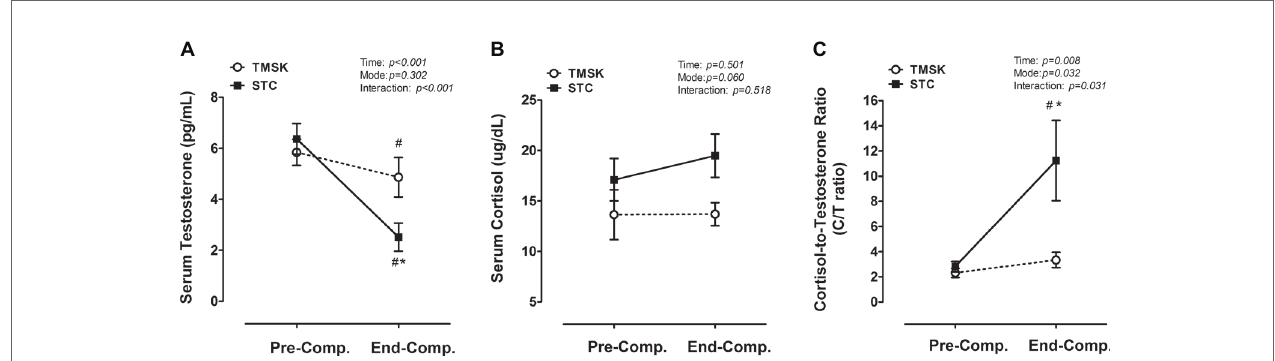
FIGURE 5 | The responses of anabolic and catabolic hormones and balance during real combat match and simulation kicking exercise. (A) Serum testosterone, (B) serum cortisol, and (C) C/T ratio. # denotes the significant difference compared to baseline values ( p < 0.05); * denotes significant difference between TMSK and STC ( p < 0.05). TMSK: TKD-match simulated kicks; STC: simulated TKD